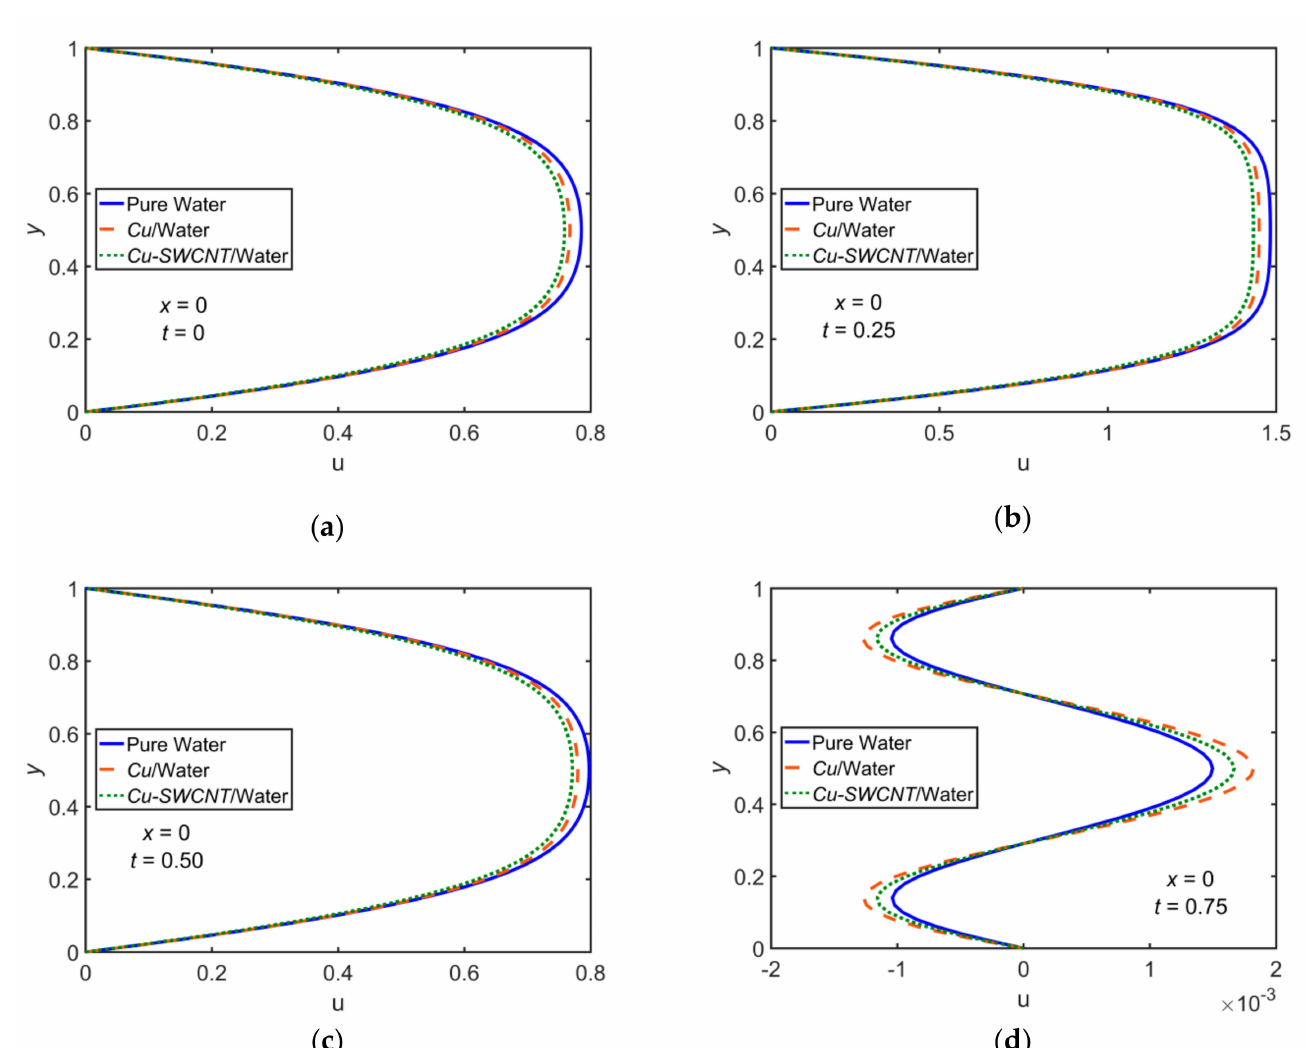
Figure 4. Comparison of pure water, Cu /water, and Cu – SWCNT /water for velocity profiles for M = 5, Pr = 1, Rd = 0.2, Re = 700, and φ = 0.02 at ( a ) t = 0, ( b ) t = 0.25, ( c ) t = 0.50, and ( d ) t =